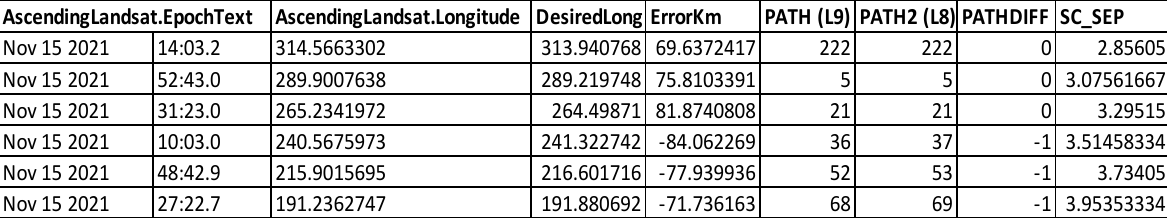
Figure 6. Example from WRS2DATA file.